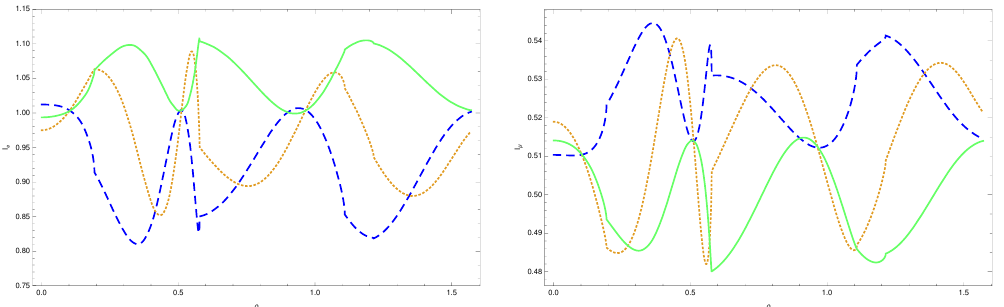
Figure 7 . I e (left panel) and I (cid:22) (right panel) for neutrinos as a function of the azimuthal angle varied from 0 to (cid:25)= 2 and (cid:12)xed E = 400 MeV. Blue dashed line: (cid:14) = 0; orange dotted line: (cid:14) = (cid:25)= 2; green solid line: (cid:14) = (cid:25) . Normal mass ordering is